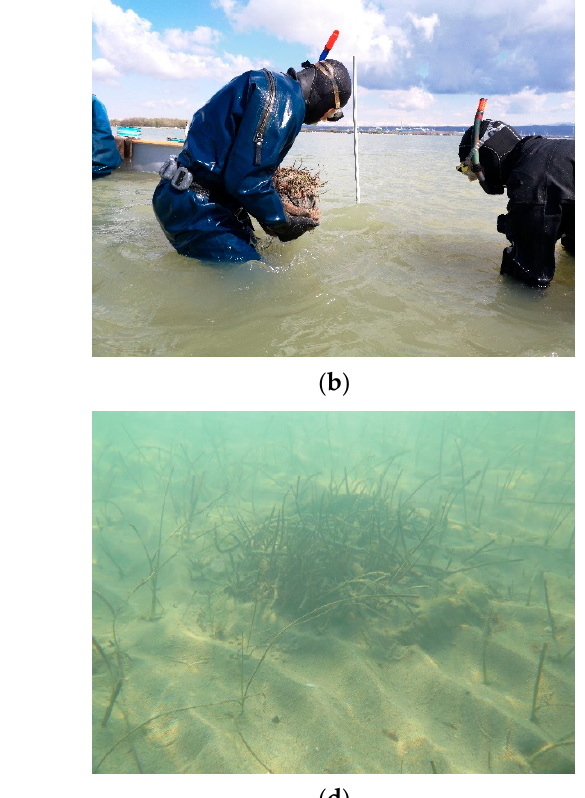
Figure 9. Panzano Bay (Gulf of Trieste) pilot transplantation by sods: ( a ) temporary storage of sods and their transport to the site to be reforested, ( b ) sods planting into the substrate by means of jute bags and ( c , d ) sods planted into the substrate.